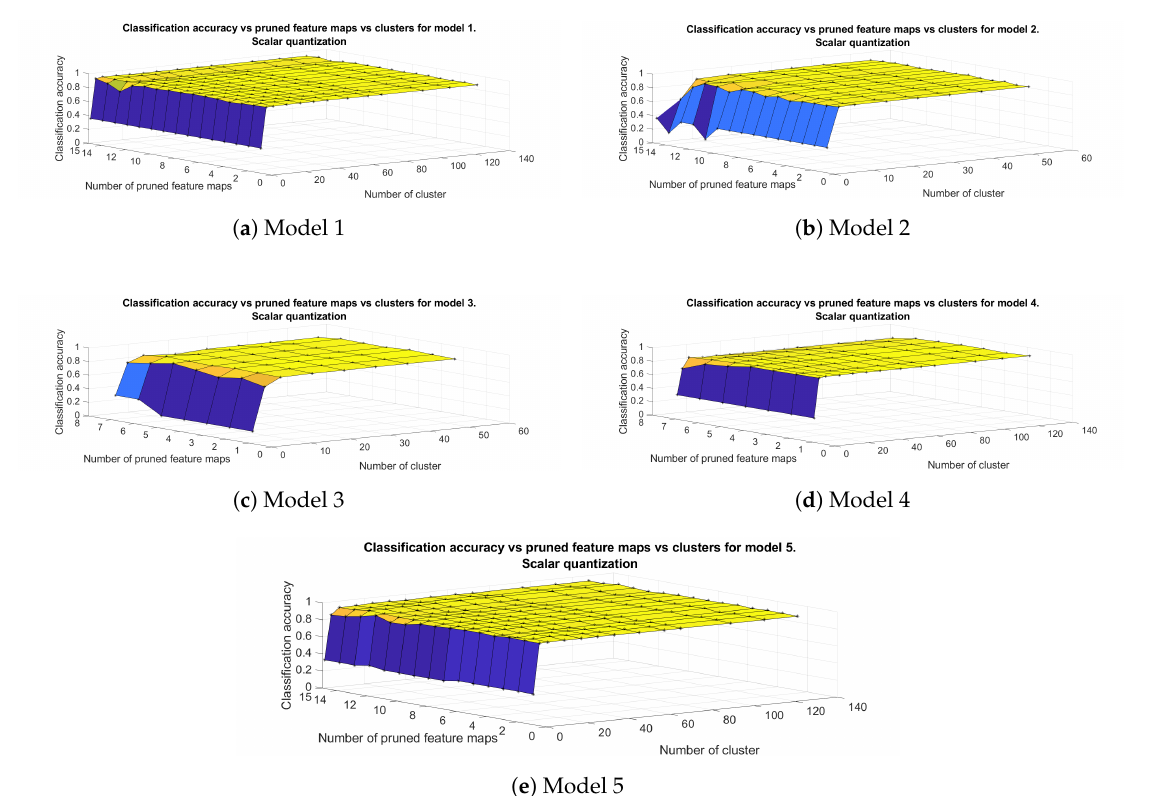
Figure 7. Classification accuracy of the different models in Table 1 that include filter pruning and scalar quantization. The horizontal axes represent the number of pruned feature map and number of clusters in fully connected layer,